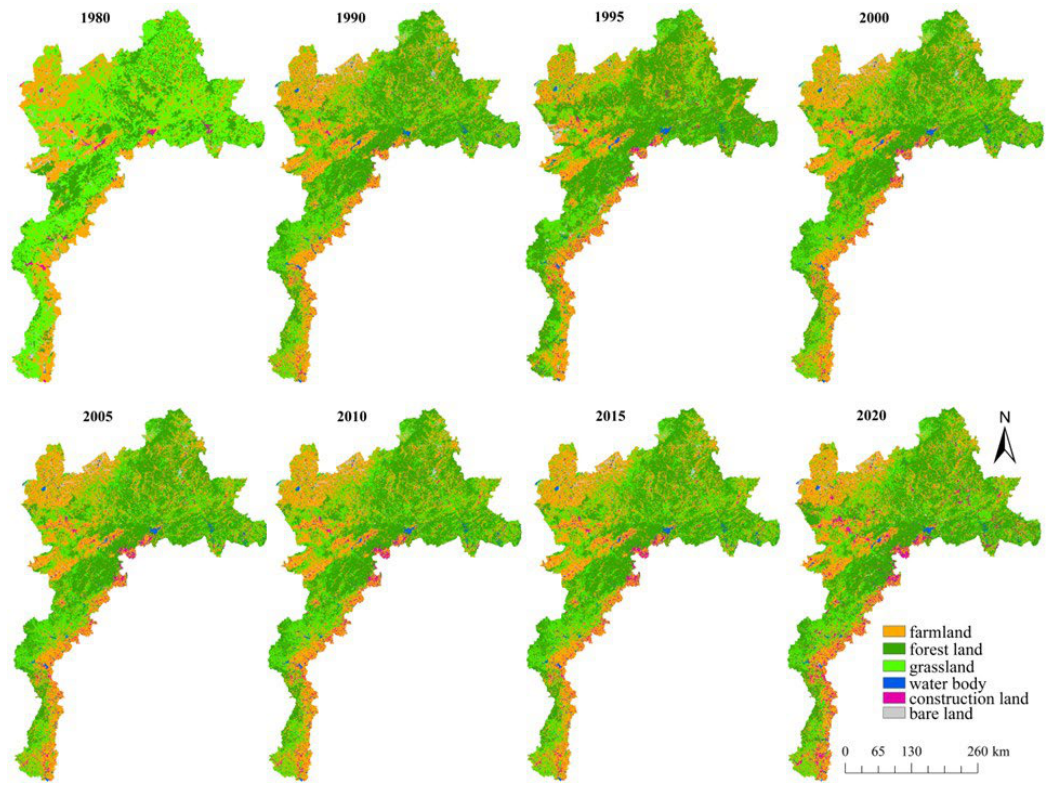
Figure 5. The spatial patterns of LULC in the eight years during